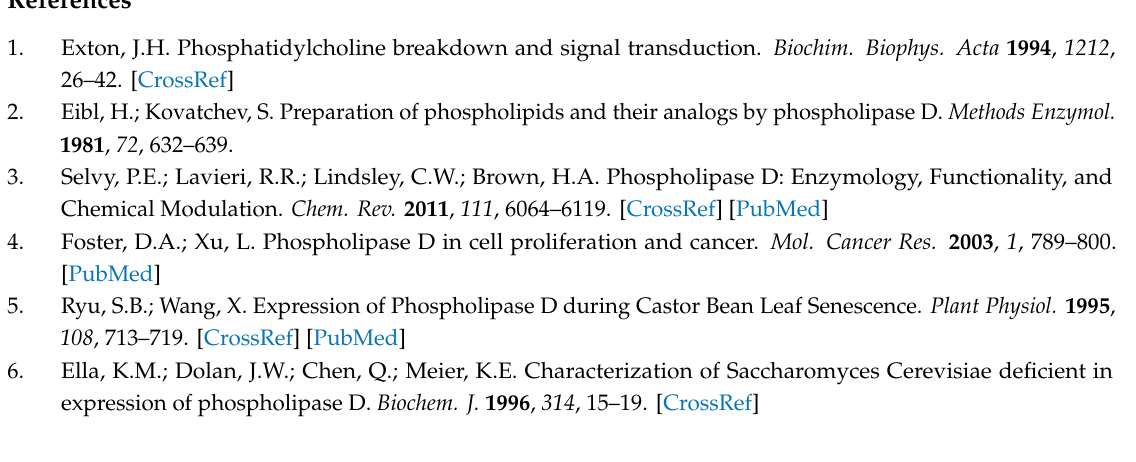
Figure 2. Di ff erent labels indicate significantly di ff erent values. Figure S1: Dependence of the choline biosensor sensitivity on the bu ff er composition (pH 8.5, I 0.1 M). Electrode rotation rate: 1000 rpm, Figure S2: Influence of pH on the response of a typical Pt / PPyox / ChO biosensor. Supporting electrolyte: acetate / phosphate / borate bu ff er I 0.1 M. Electrode rotation rate: 1000